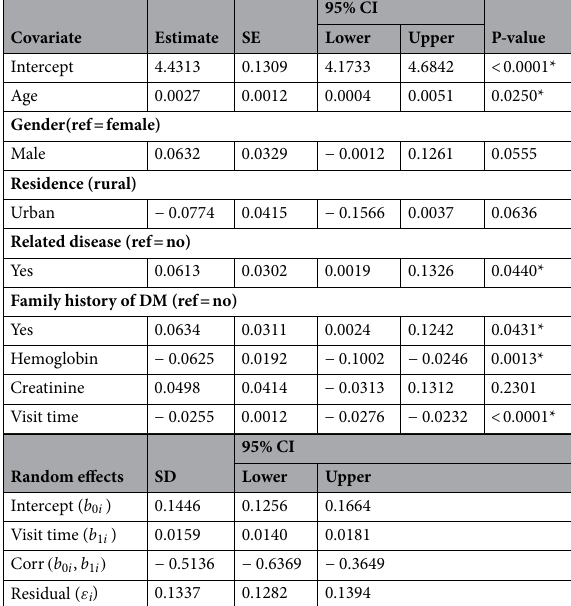
Table 4. Final linear mixed model result of longitudinal lnFBS. SE Standard error, SD Standard deviation; *Stands for statistically significant variable at 5% level of